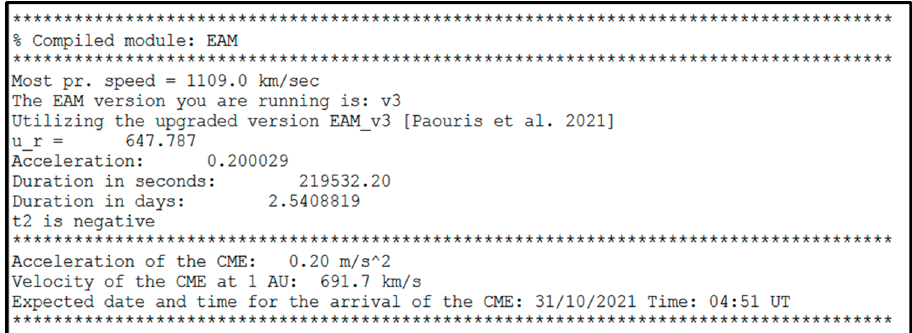
Figure 11 . The report from the Effective Acceleration Model—EAMv3 [25].